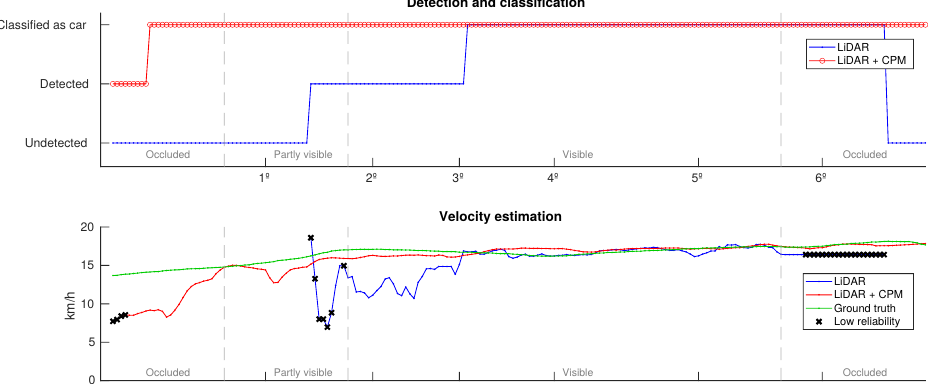
Figure 12. Comparison of the velocity and classification obtained with and without CPM